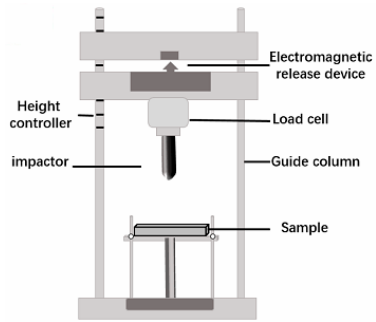
Figure 2. Drop-weight impact tester.